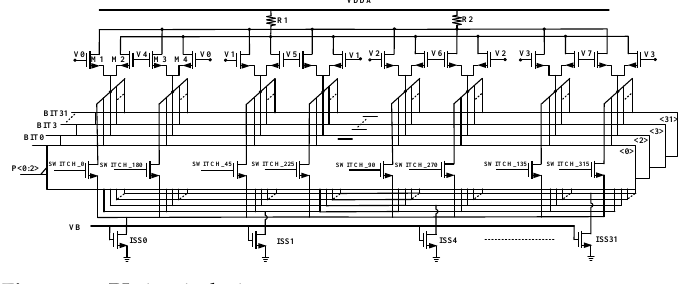
Figure 18. PI circuit design.